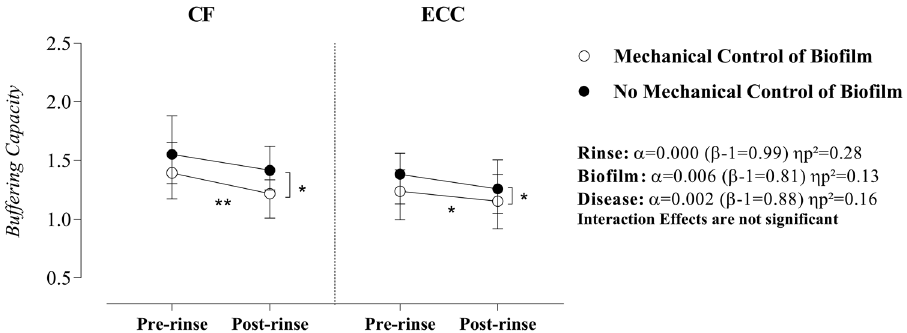
Figure 3. Effect of rinse, mechanical control of biofilm, and disease on saliva buffering capacity. Statistical analyses were performed with a sample of 56 volunteers, 28 per group. ηp 2 : Partial eta squared. Data plotted as median and interquartile range (due to non-Gaussian distribution). To fulfill the ANOVA premises, we used the log10 transformation. Non-significant interactions were suppressed. A single asterisk represents a significant p-value ≤ 0.05. A double asterisk represents p-value ≤ 0.01. Simple effects for Rinse in CF children—Mechanical control of biofilm: α = 0.007 (β-1 = 0.79) ηp 2 = 0.13 and No mechanical control of biofilm: α = 0.23 (β-1 = 0.22) ηp 2 = 0.03). Simple effects for Rinse in children with ECC—Mechanical control of biofilm: α = 0.01 (β-1 = 0.72)